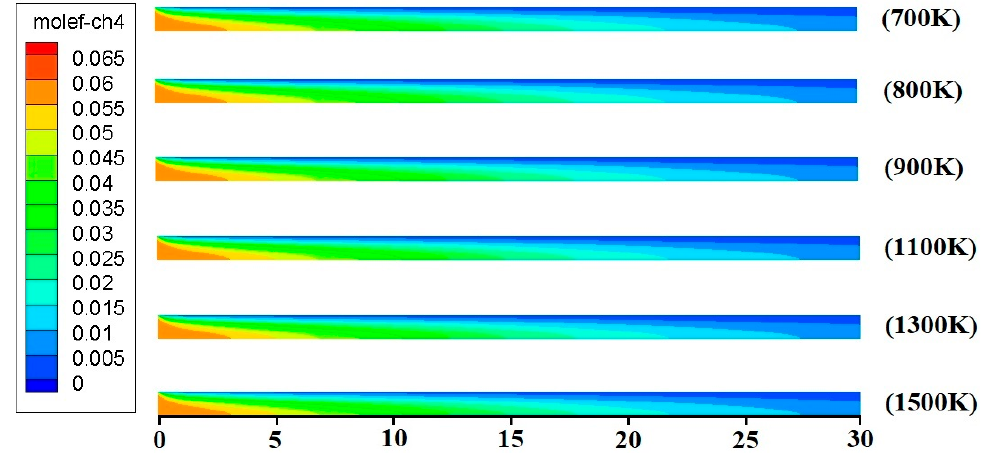
Figure 11. Distribution of methane concentration with different ignition temperatures.